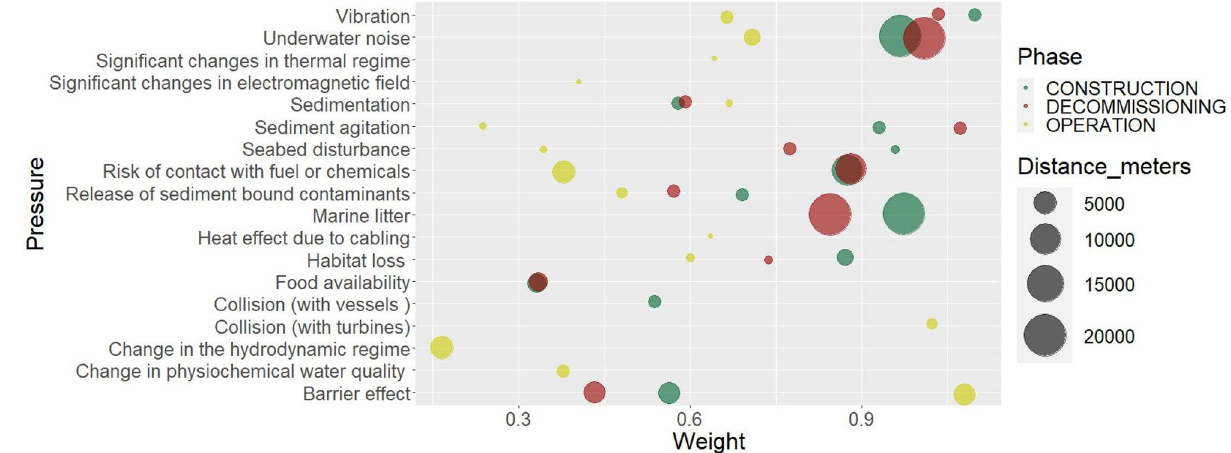
Figure 8. Pressure weights and pressure propagation distance in meters in each of the development phases of the offshore wind